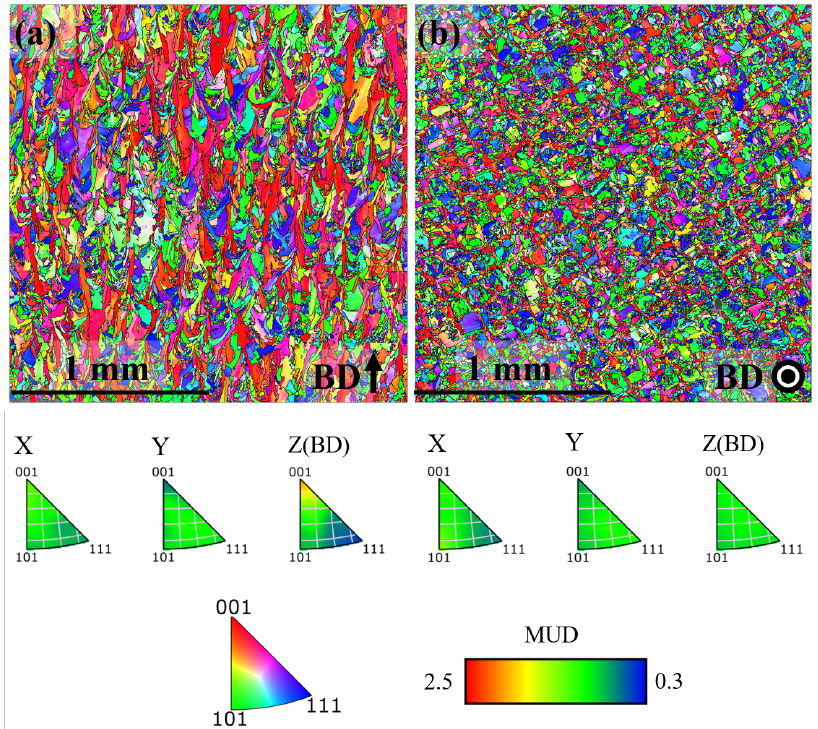
Figure 5. IPF map in the DA condition ( a ) x-z plane ( b ) x-y